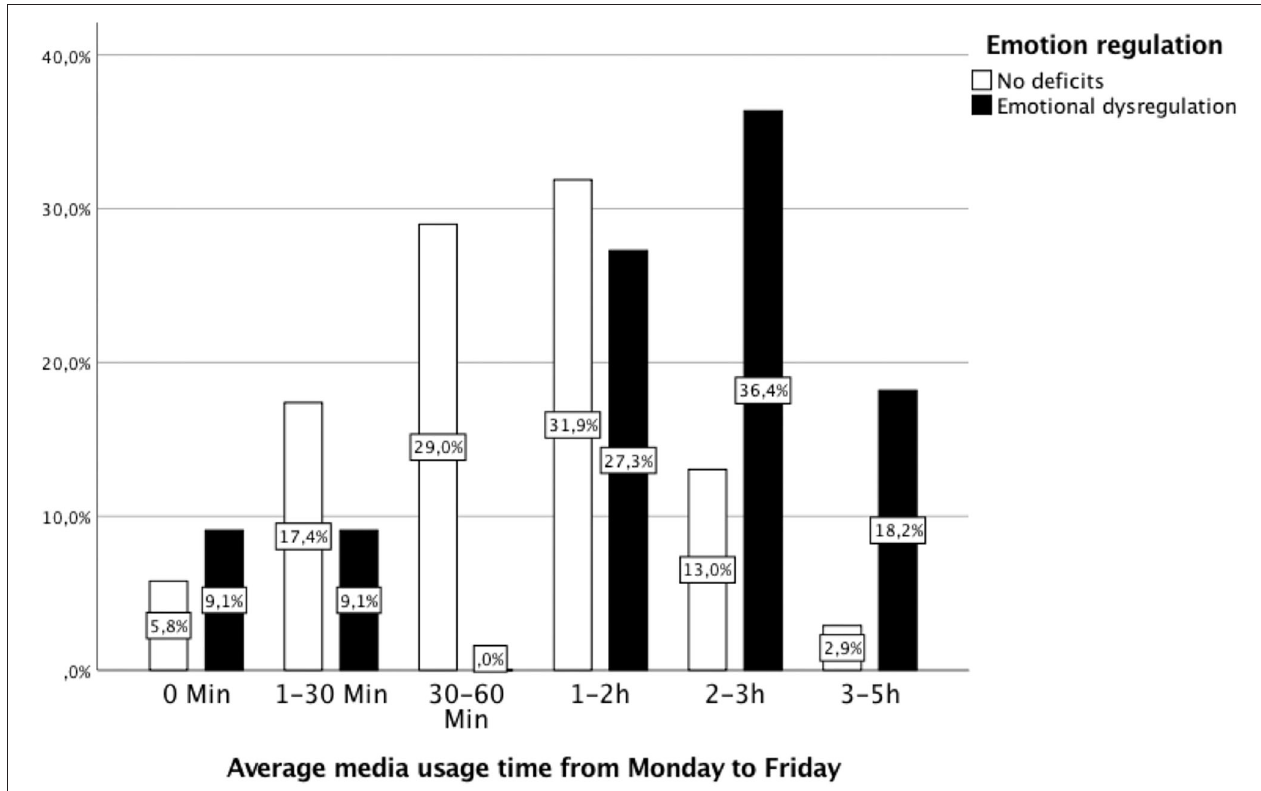
FIGURE 3 | Daily average media usage time from Monday to Friday by children with ED and without ED. Children with ED used media significantly longer on weekdays than children without ED (Mann–Whitney U -test: M rank with ED = 55.77, M rank without ED = 38.07; U = 211.5, Z = − 2.41, p = 0.016).